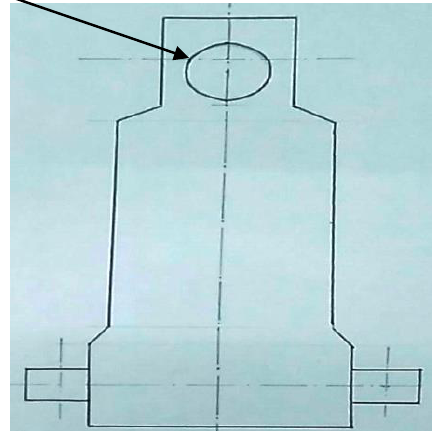
Figure 8. Bottom case with shifted axle Before implementation